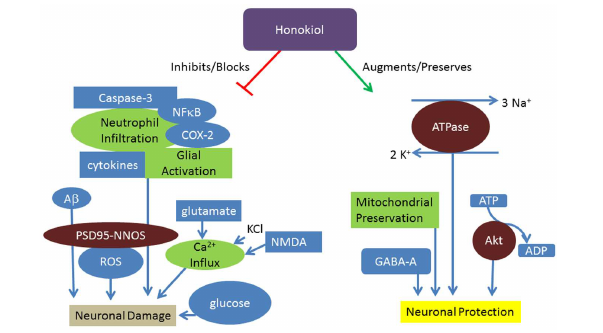
FIGURE 1 | Honokiol promotes neuroprotection through various mechanisms . Honokiol results in neuronal protection through preservation of Na + /K + ATPase, phosphorylation of pro-survival factors, preservation of mitochondria, and modulation of GABA A . Honokiol further promotes neuronal health through prevention of glucose, ROS, and inflammatory mediated